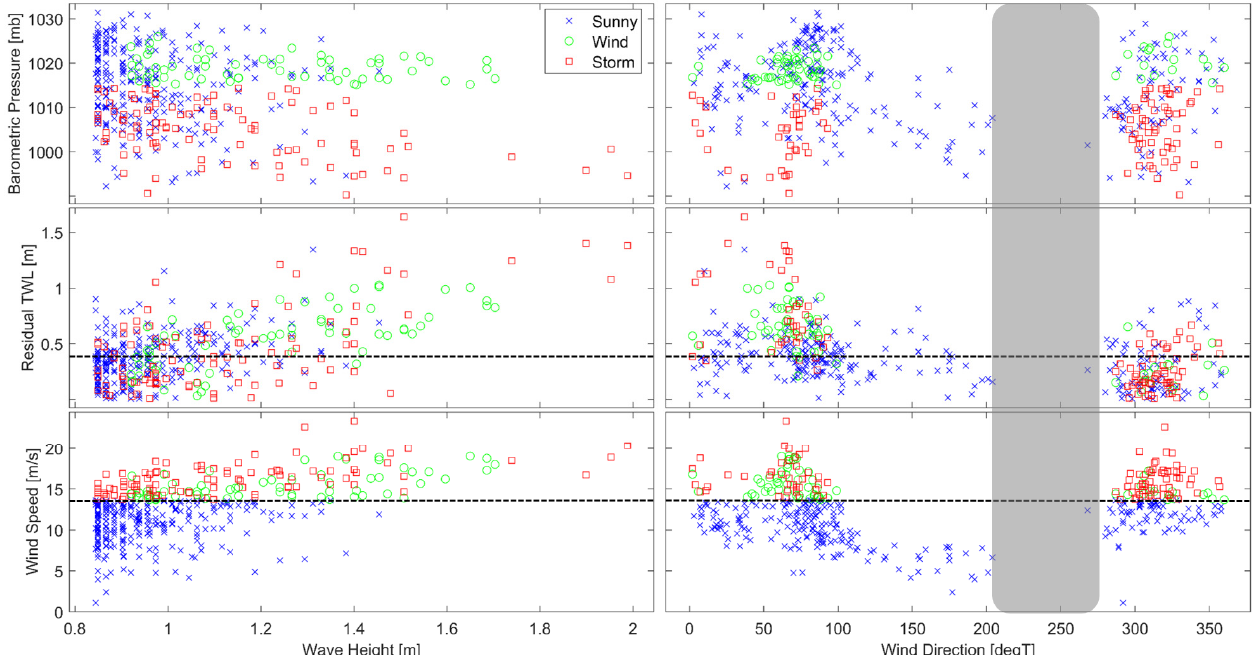
Figure 5. The above scatter plots show the results of the conditional event identification process based on 95% thresholds ( H s , TWL res , and U 10 ). These types are compared to the barometric pressure (top row) and wind direction (right column) for 2015 to 2019. The grey shaded region denotes compass directions overland. The black dashed lines are the threshold for the respective parameters (see Table 2 for the values).